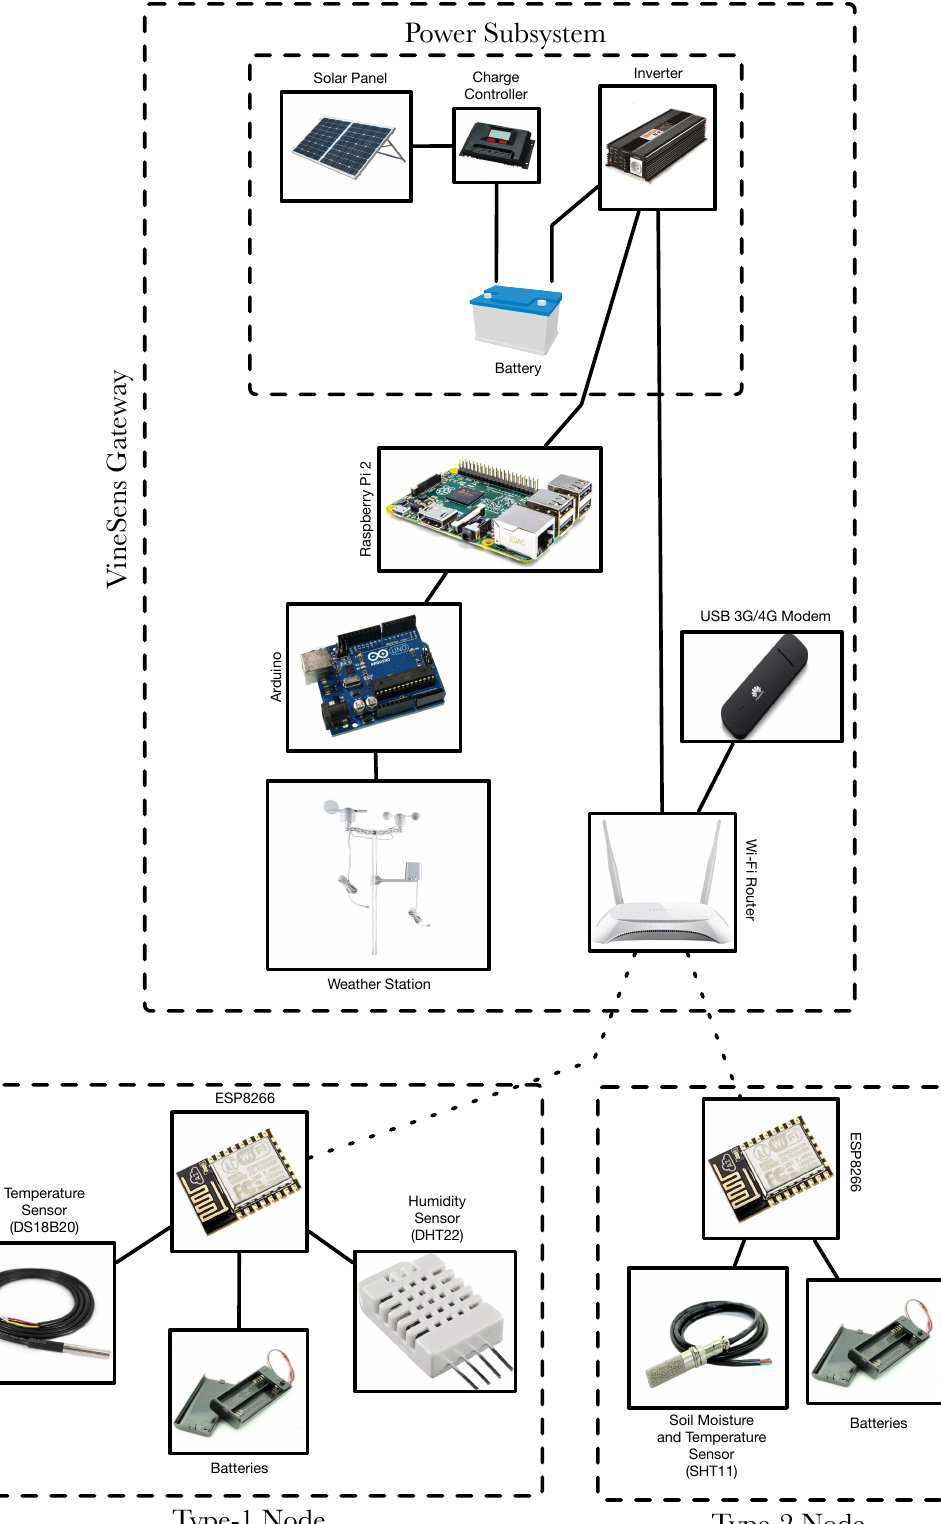
Figure 3. VineSens’ hardware